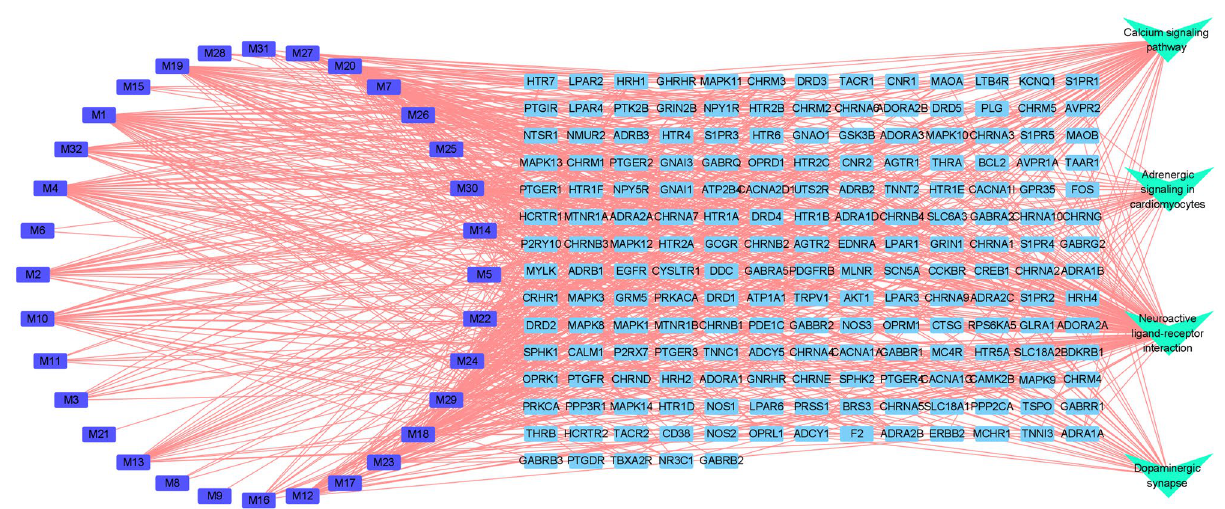
Figure 7. Compound-target-pathway network showing the comprehensive toxic mechanism of Fuzi. From left to right, the nodes correspond to compounds in Fuzi, targets of Fuzi responsible for toxicity, and the enriched pathways responsible for the toxicity. The full name of compounds and targets are shown in Table 1 and Supplementary Table S1,